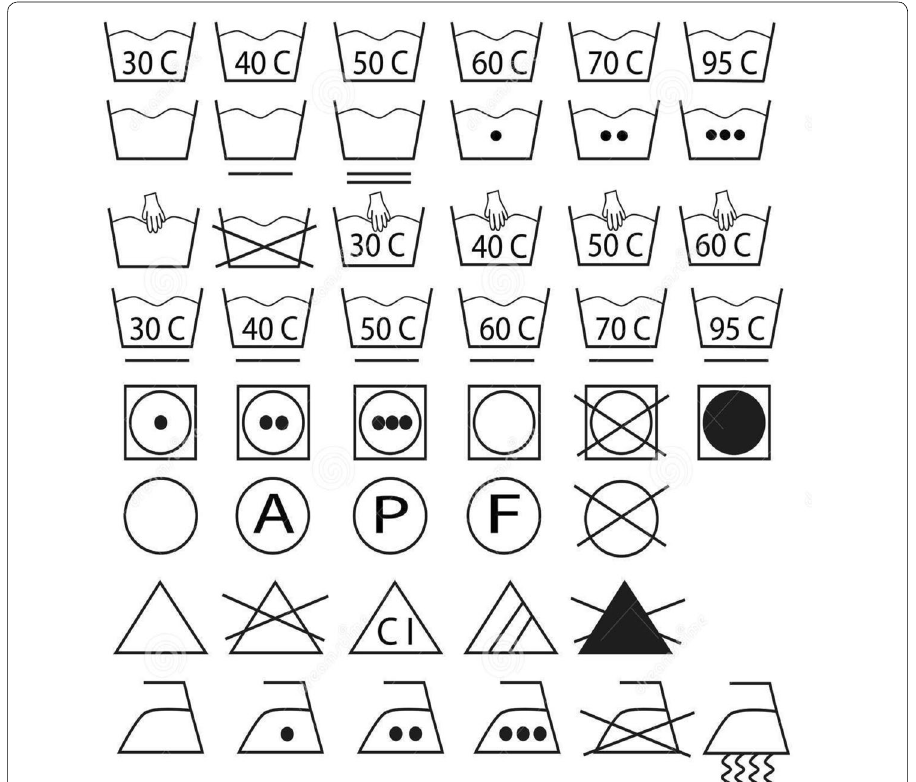
Fig. 2 Conservation pictograms (Source: Ginetex